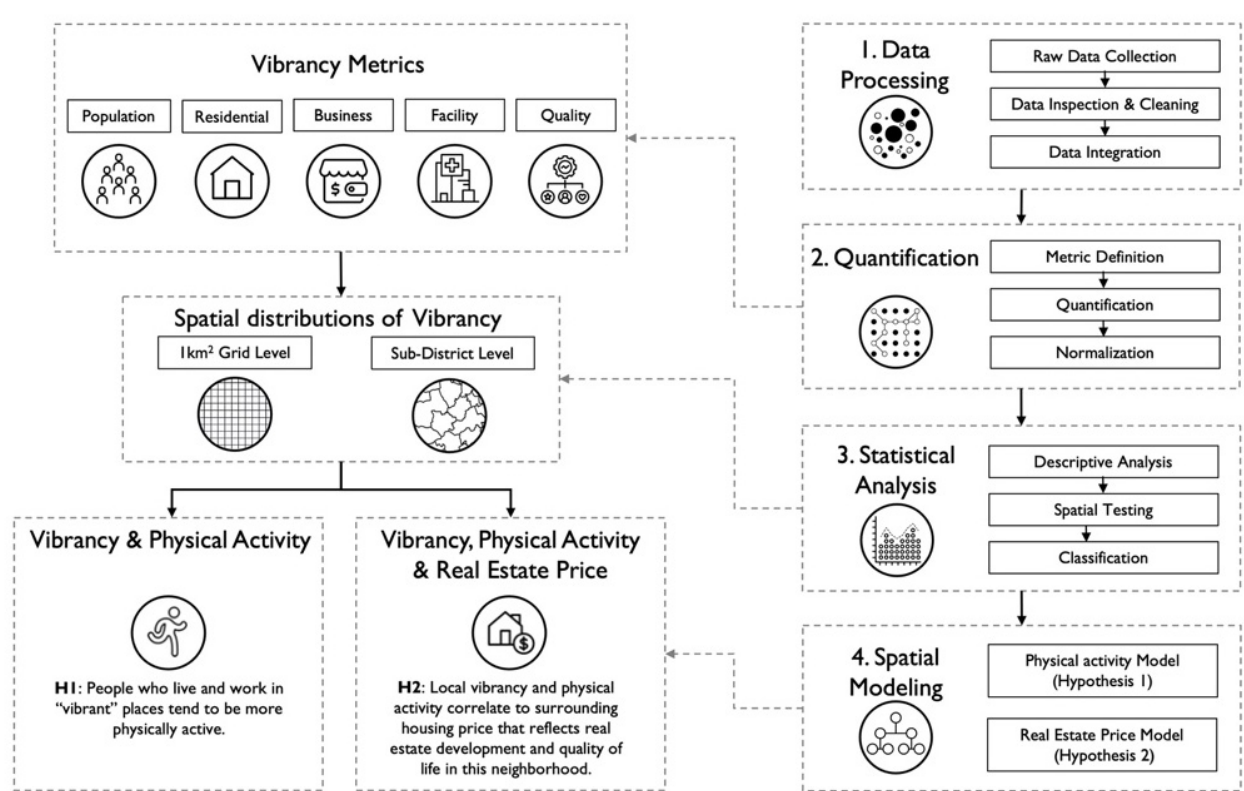
Figure 1. The research framework for this study.